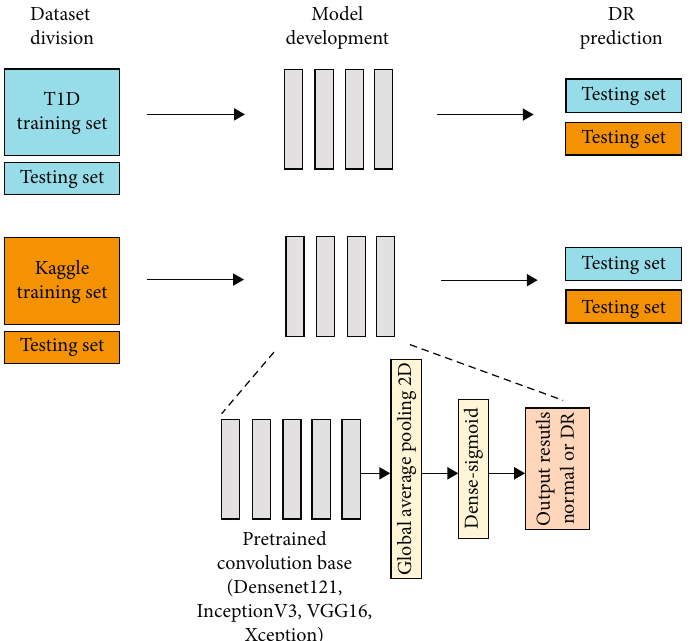
Figure 2: Schematic of the development and evaluation of models. Two groups of models were trained using the T1D and Kaggle training sets, and they were tested with both the T1D and Kaggle testing sets.